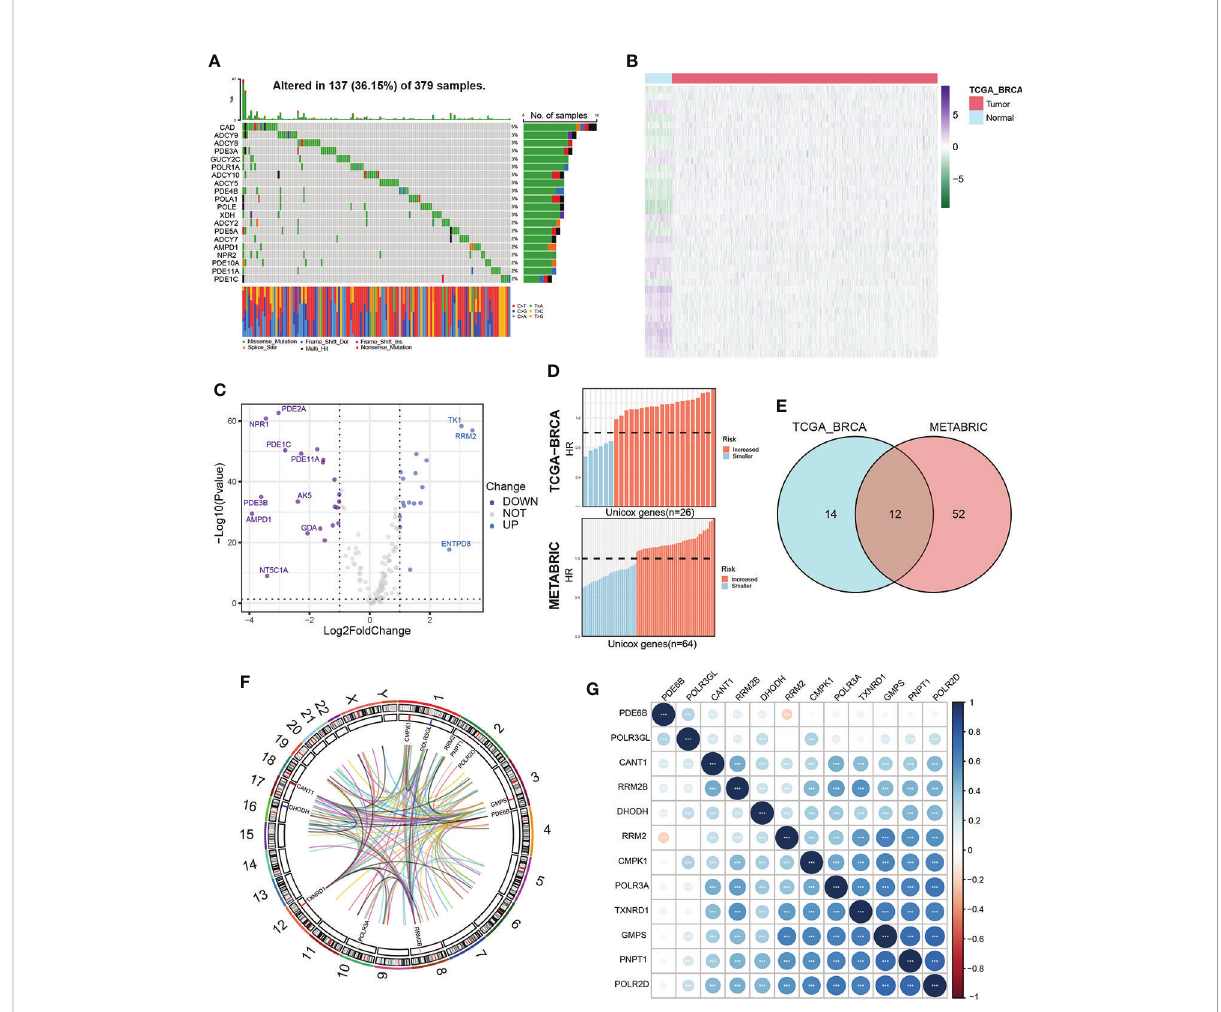
FIGURE 2 Characterization of prognosis-related PMGs in BC patients. (A) The somatic mutation frequency of PMGs in the TCGA-BRCA cohort. (B, C) Differentially expressed PMGs between normal and tumor tissues in TCGA-BRCA were shown in a heatmap and a volcano plot successively. (D) Prognostic PMGs were screened by the univariate Cox analysis in TCGA-BRCA and METABRIC severally. (E) A Venn diagram to obtain 12 overlapping prognostic PMGs. (F) A circos plot depicting the chromosomal location of the 12 prognostic PMGs and the chromosomal location of their interacting genes and describing the expression levels of the 12 PMGs. (G) The correlation characteristics between the 12 prognostic PMGs in TCGA-BRCA was revealed with a correlation matrix